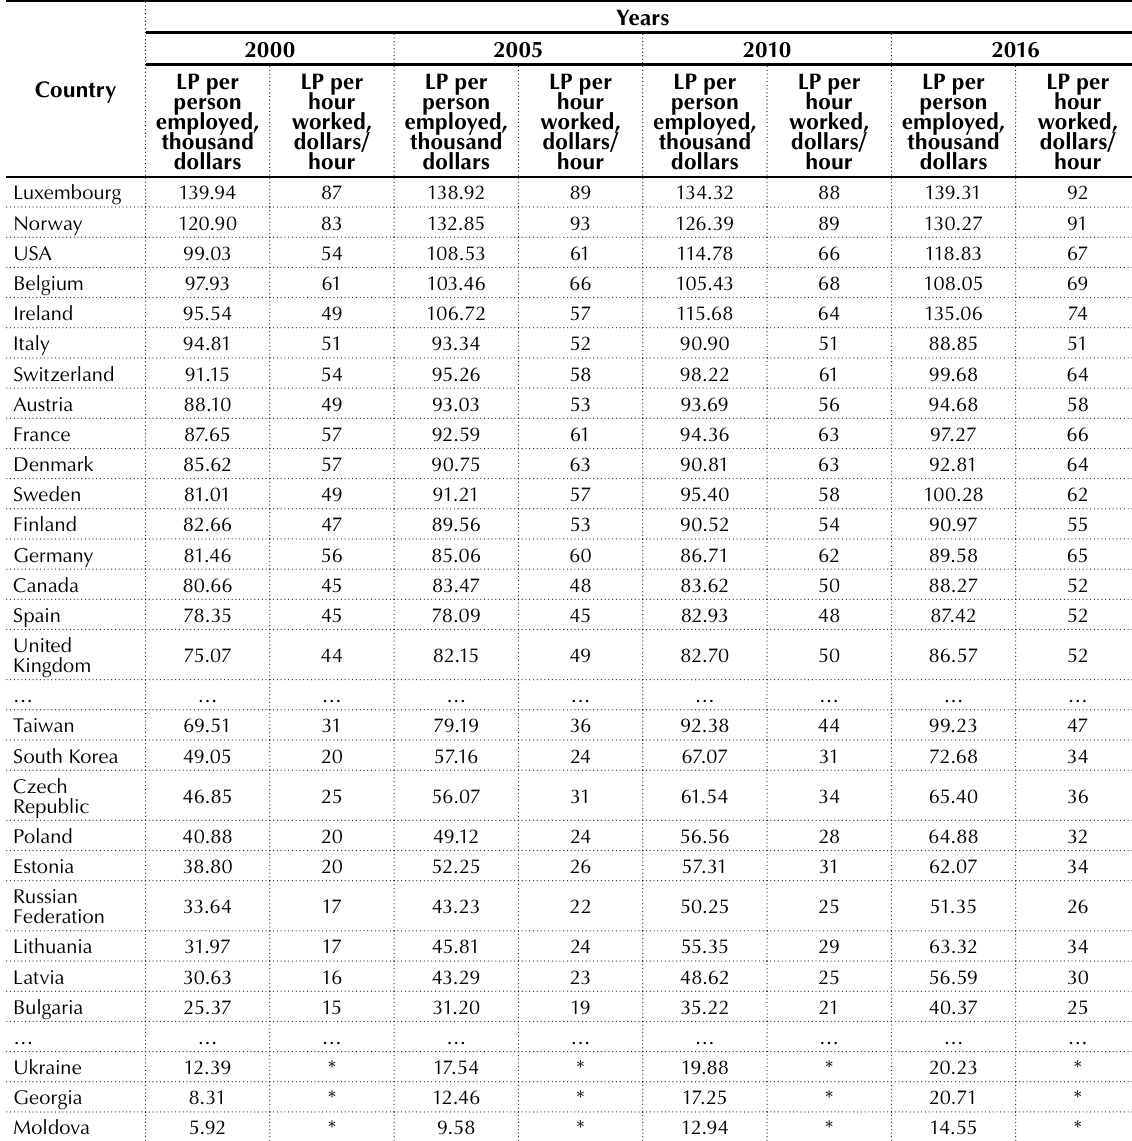
Table 1. Labor productivity in countries with different levels of economic